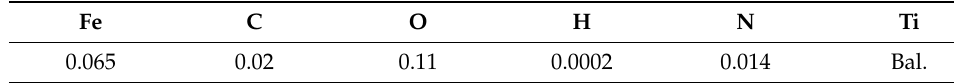
Table 1. chemical composition in wt (%) of TA2.